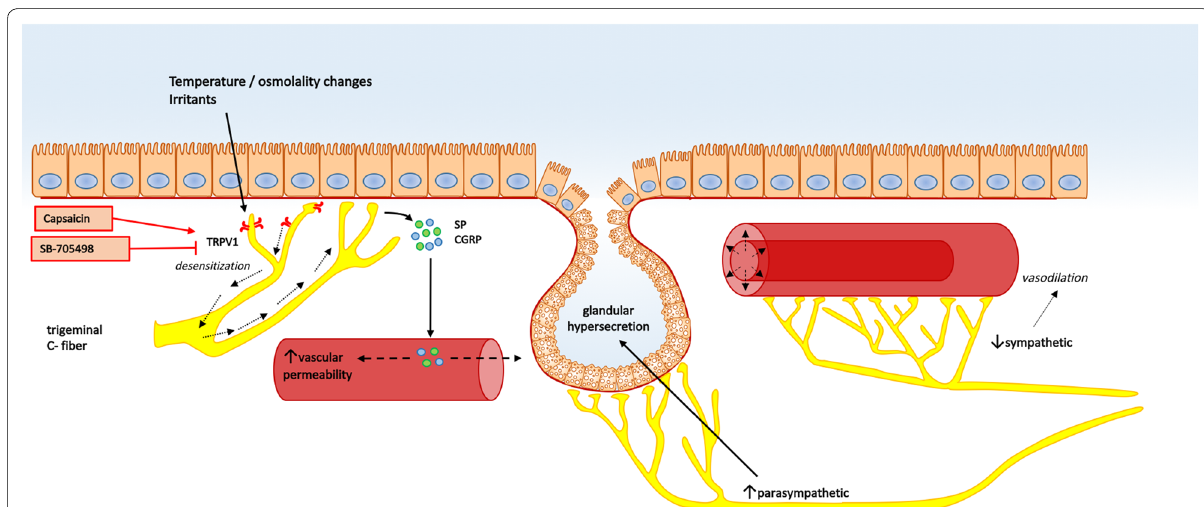
Fig. 4 Neurogenic endotype and biologicals. TRPV1 overexpression resulting in nasal hyperreactivity on temperature and/or osmolality changes and irritants ( left side ). Dysautonomia ( right side ). CGRP calcitonin G-related peptide; SP substance P; TRPV1 transient receptor potential vanniloid